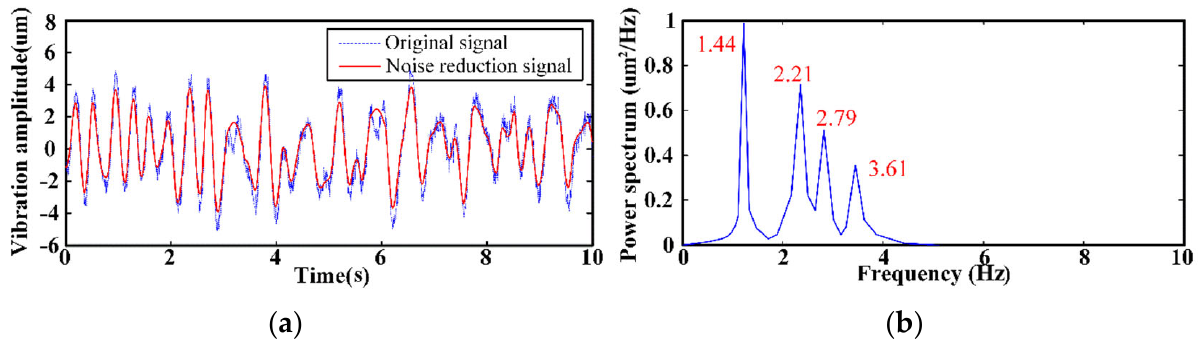
Figure 8. Time history diagram and the normalized power spectrum diagram after noise reduction. ( a ) Time history signals; ( b ) Normalized power spectra.